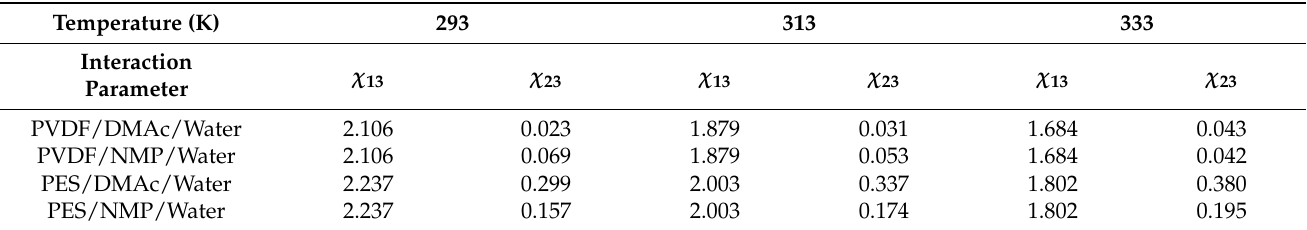
Table 6. Binary interaction parameters ( χ 13 and χ 23 ) at different temperatures from solubility parameters with α 13 = α 13 = 1 and χ 123 = 0.